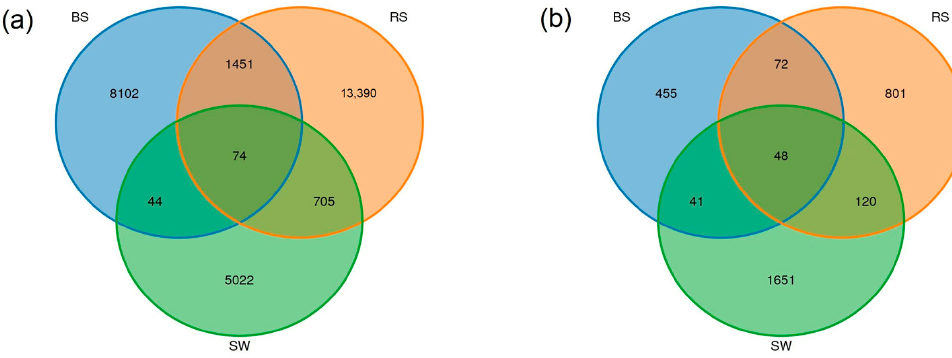
Figure 5. Venn diagrams showing the shared and unique bacterial ( a ) and fungal ( b ) ASVs among RS, BS and SW groups. RS: the seagrass rhizosphere soil samples; BS: sediment samples; SW: seawater samples. Each circle represents sampled compartments. Values within intersections represent shared ASVs, values outside intersections represent unique ASVs.